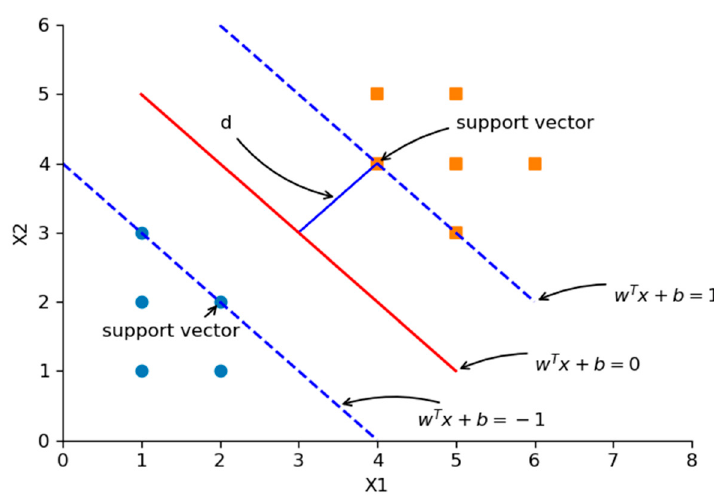
Figure 4. Principle of support vector machine (SVM).